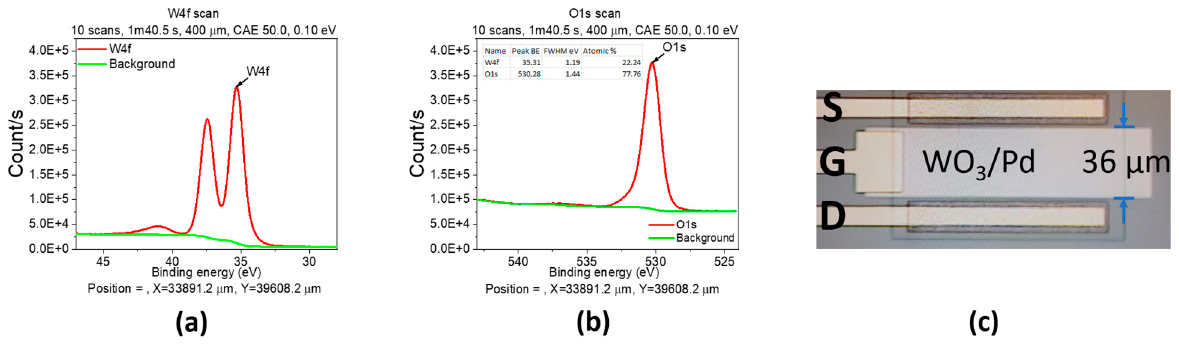
Figure 2. The X-ray photoelectron spectroscopy spectra for W4f and O1s of Si test sample ( a , b ) and the microscope image of the fabricated device ( c ).